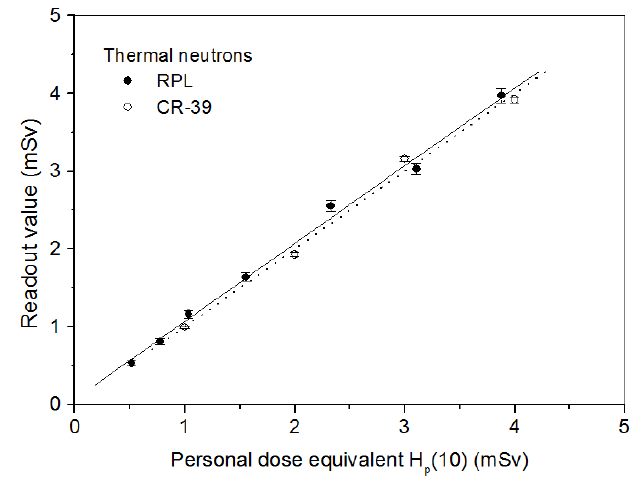
Figure 5. RPL and CR-39 detector responses at normal incidence to thermal neutrons as a function of personal dose equivalent H p (10).